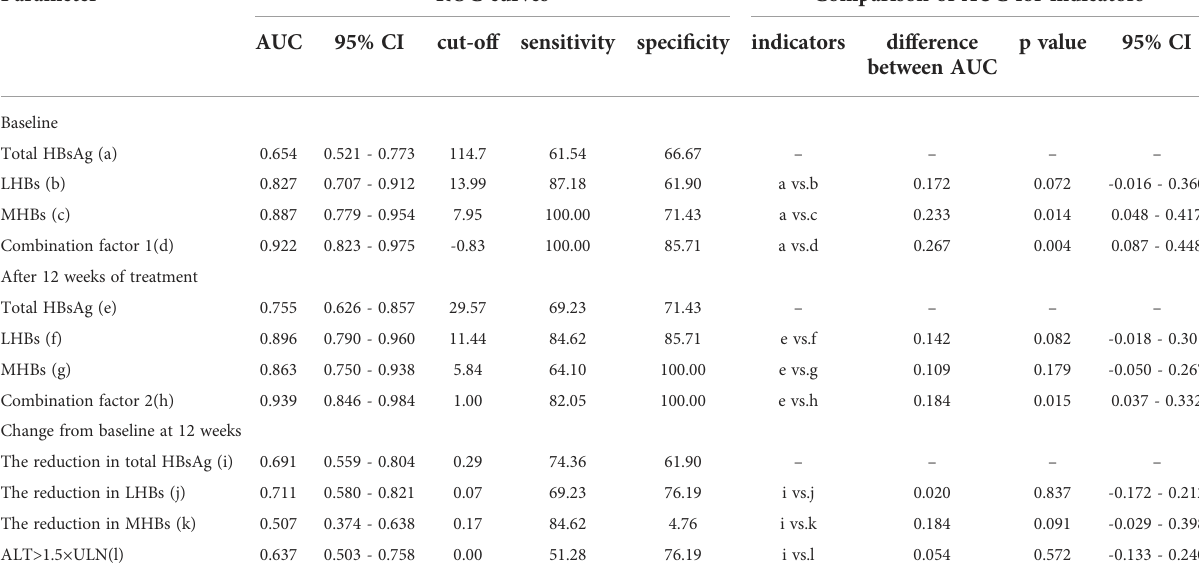
TABLE 3 ROC curves for the prediction of HBsAg loss in